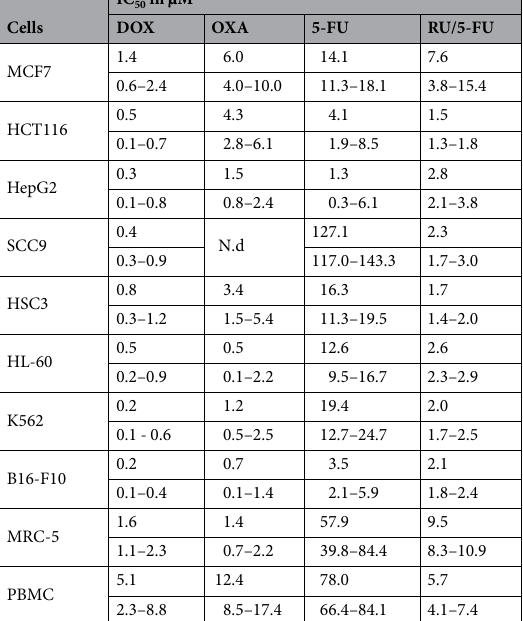
Table 1. Cytotoxic activity of the complex [Ru(5-FU)(PPh 3 ) 2 (bipy)]PF 6 (RU/5-FU). Data are presented as IC 50 values in μ M and their respective 95% confidence interval obtained by nonlinear regression from at the least three independent experiments performed in duplicate, measured by alamar blue assay after 72 h incubation. Cancer cells: MCF7 (human breast carcinoma); HCT116 (human colon carcinoma); HepG2 (human hepatocellular carcinoma); SCC-9 (human oral squamous cell carcinoma); HSC-3 (human oral squamous cell carcinoma); HL-60 (human promyelocytic leukemia); K-562 (human chronic myelogenous leukemia); and B16-F10 (mouse melanoma). Non-cancer cells: MRC-5 (human lung fibroblast) and PBMC (human peripheral blood mononuclear cells). Doxorubicin (DOX), oxaliplatin (OXA) and 5-fluorouracil (5-FU) were used as the positive controls. N.d. Not determined.